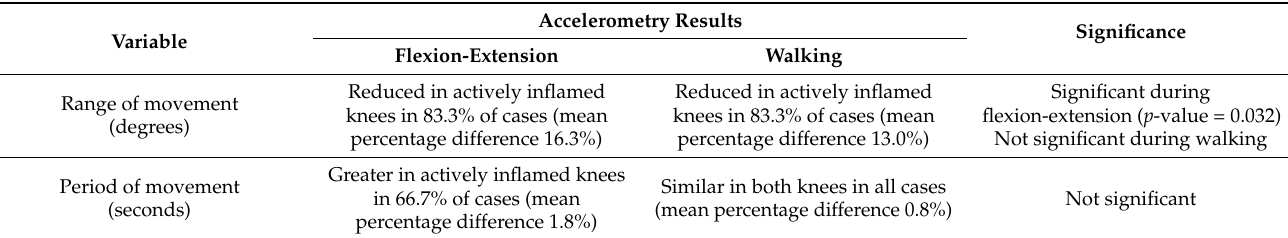
Table 4. Summary of the relationship between accelerometry